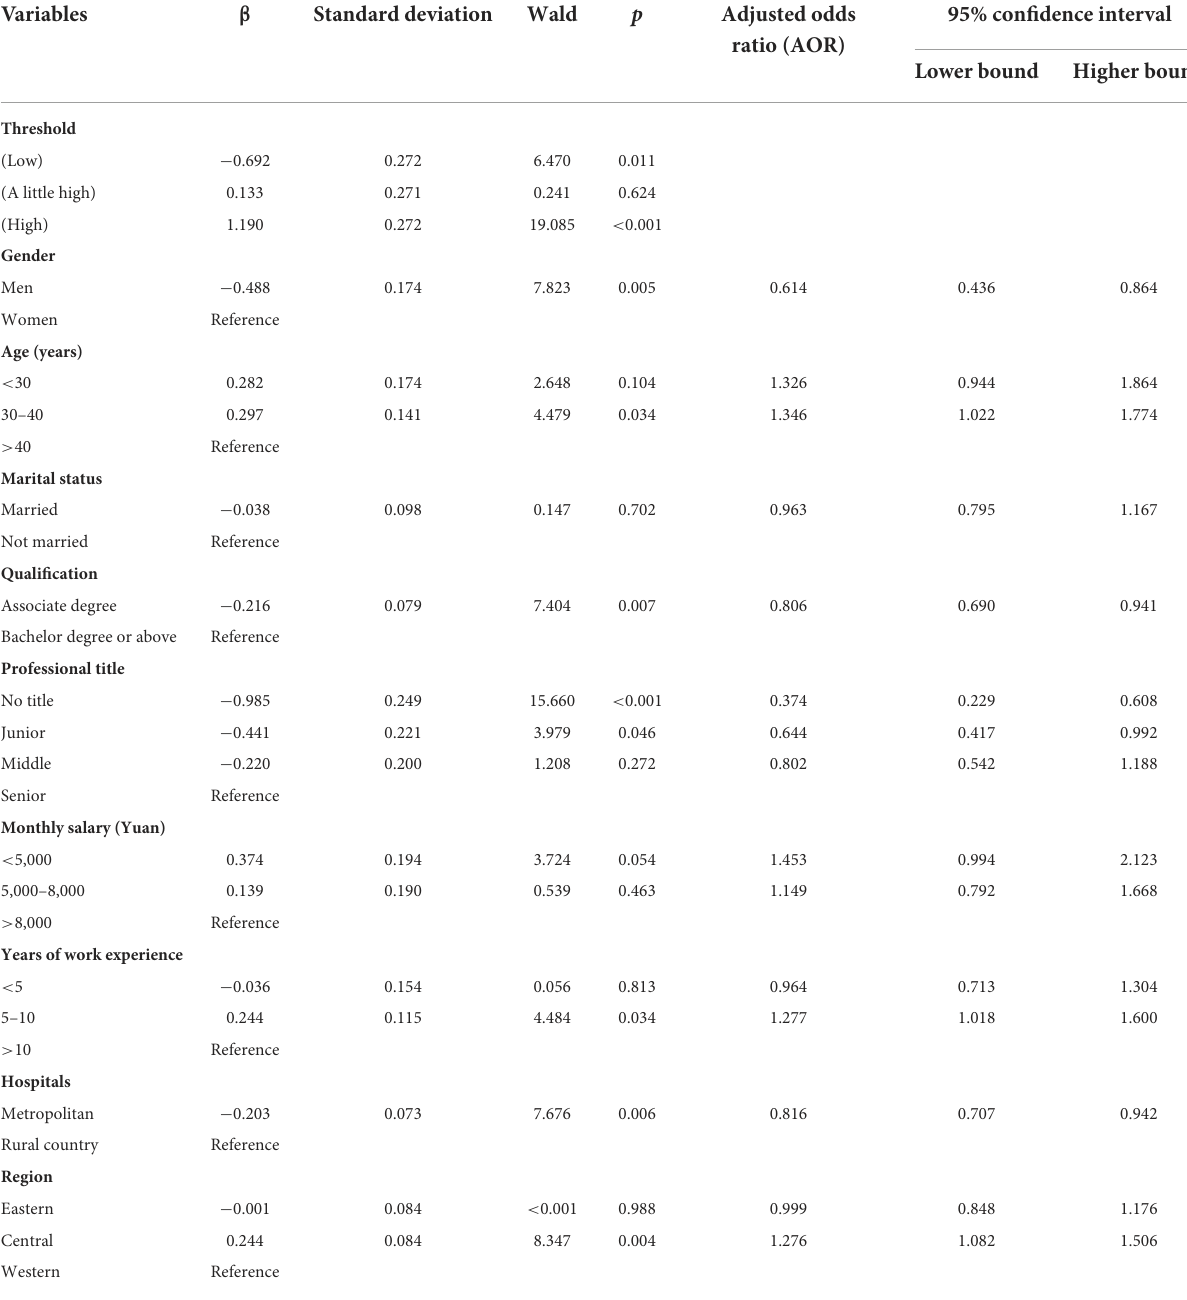
TABLE 5 Predictors of work-related accumulative fatigue-ordinal logistic regression modeling ( n =